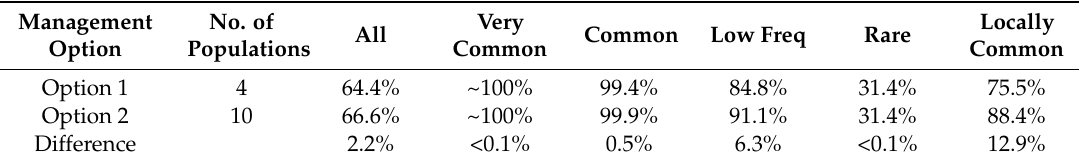
Table 2. Proportion of genetic diversity preserved in 61 trees, whether these trees are chosen from 4 (option 1) or 10 (option 2) populations, randomly.